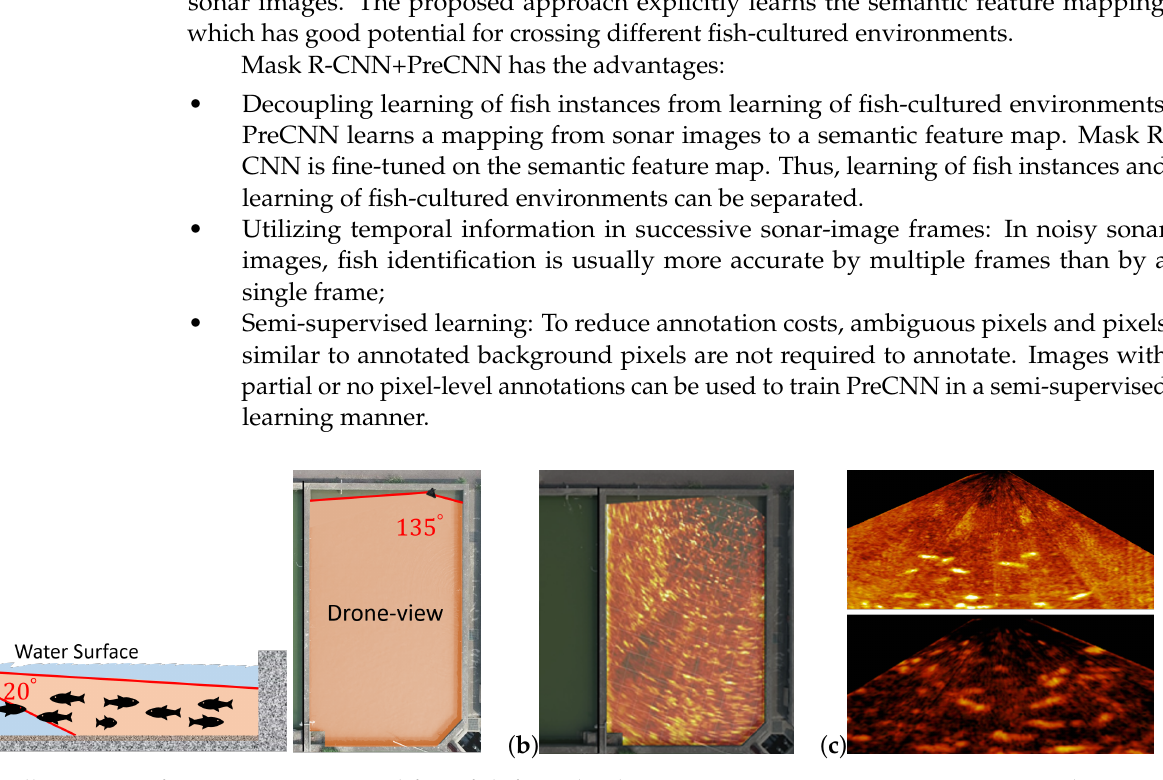
Figure 2. Illustrations of sonar images acquired from fish farms by the Garmin CHIRP imaging sonar system, where ( a ) depicts the underwater area covered by the imaging sonar system; ( b ) is a drone-view of a fish pond overlapped with the rectified sonar image; ( c ) shows two sonar images acquired from different land-based fish